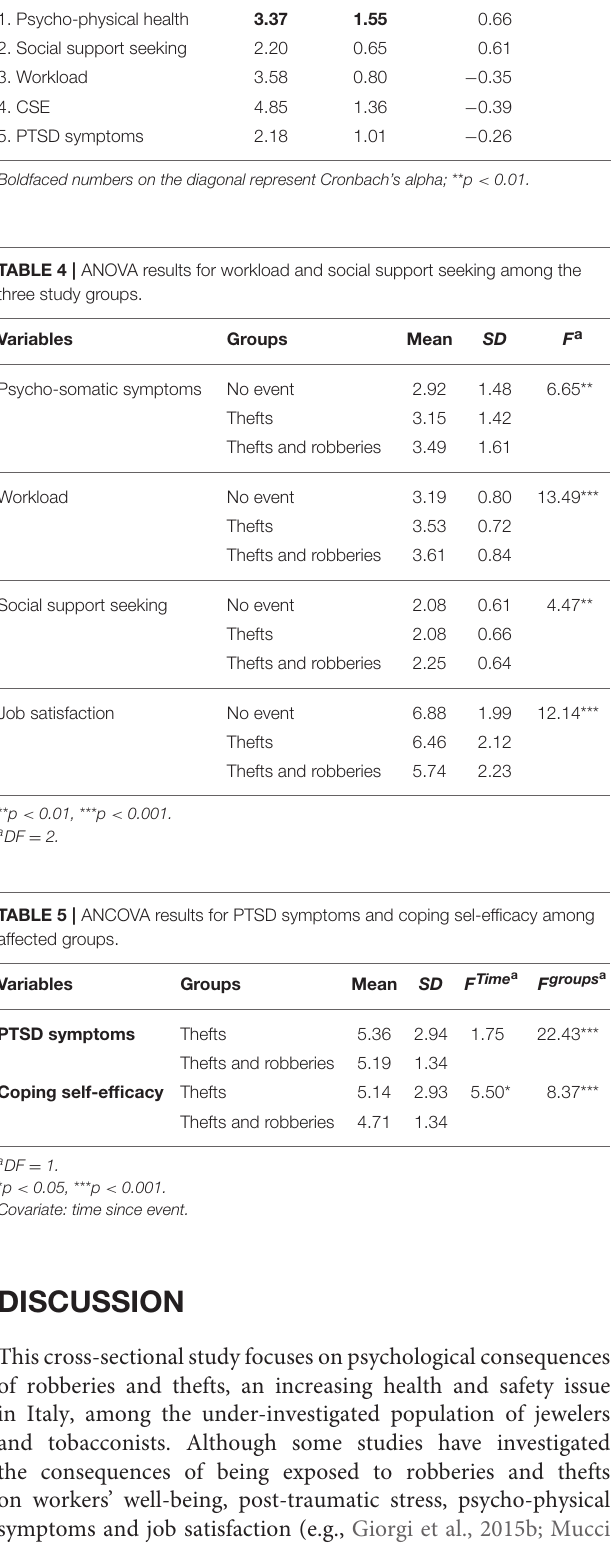
TABLE 3 | Descriptive, internal consistency, and intercorrelations for study variables among affected workers ( N = 319). Measure M